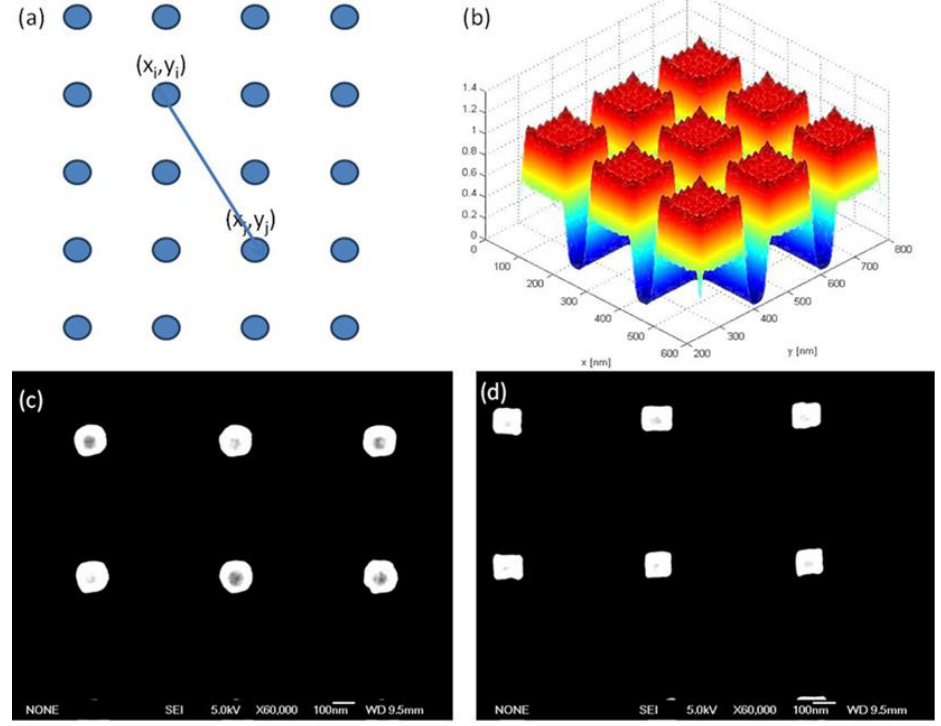
Figure 2. ( a ) Schematic diagram of the electron beam exposure points. ( b ) Schematic diagram of the exposure dose at each point in the 100 nm square region calculated by MATLAB (2016b, Math- Works,CA, USA). ( c ) Electron micrograph of a square 2D grating structure without proximity effect correction, with a side length of 100 nm. ( d ) Electron micrograph of a square 2D grating structure with proximity effect correction, with a side length of 100